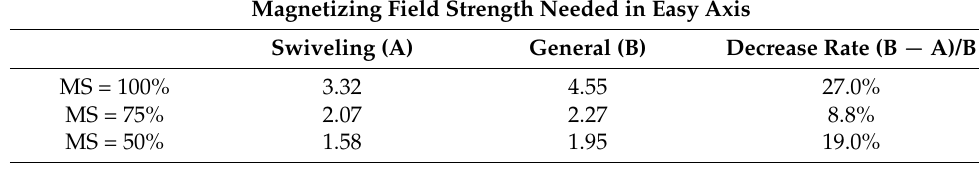
Table 3. Comparison of external magnetizing field strength required by the swiveling method and the general method in the easy axis and hard